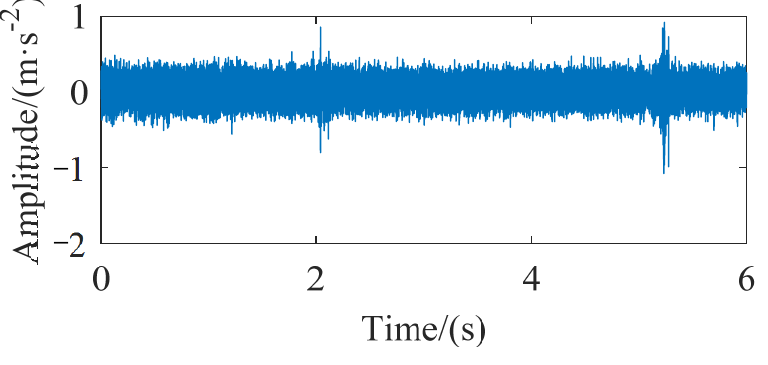
Figure 19. The signal from the EMU.